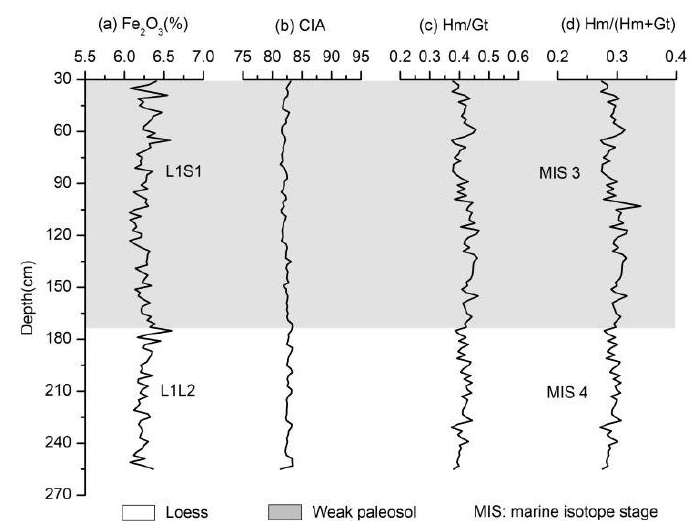
Figure 4. Vertical distribution characteristics of ( a ) Fe 2 O 3 concentration, ( b ) CIA, ( c ) Hm/Gt ratio and ( d ) Hm/(Hm + Gt) ratio for the CQS section.